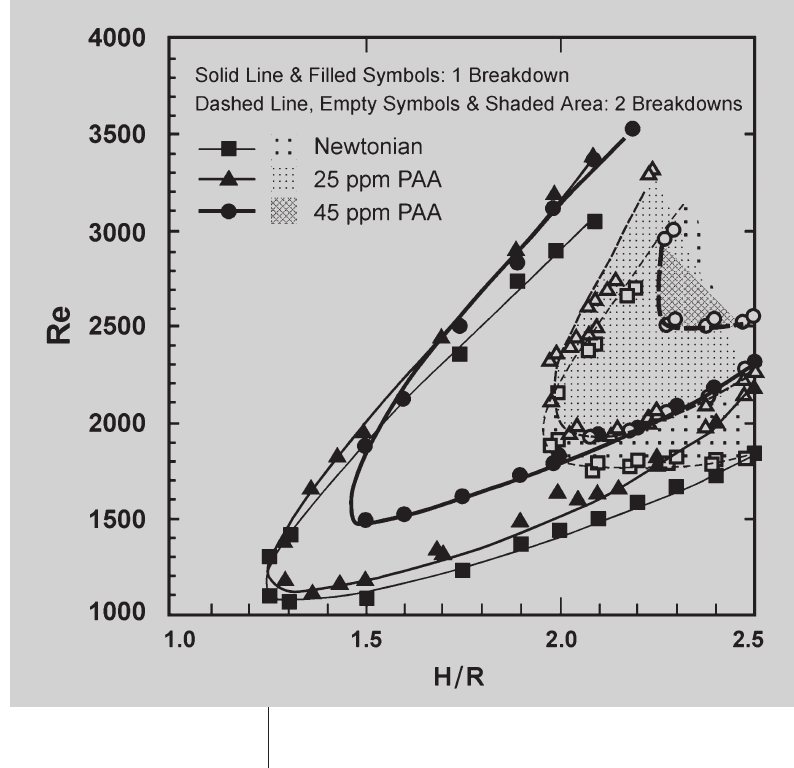
Figure 13: Existence domain for vortex breakdown of low viscosity polyacrylamide Boger fluids and the Newtonian